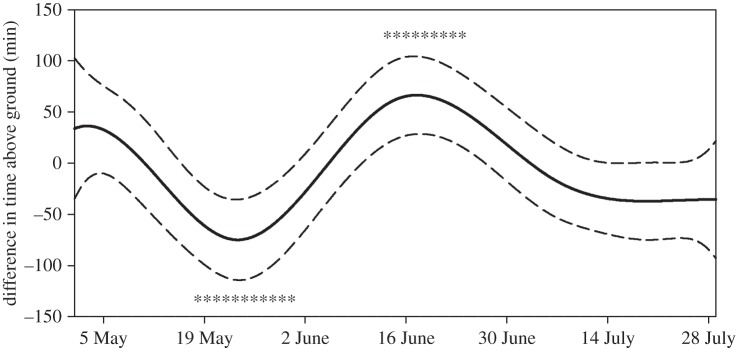
Predicted differences in p-splines between the sexes for time spent above ground each day by arctic ground squirrels across the 2014 active season at Atigun River. The solid line shows the mean prediction and the dotted lines, the 95% CIs. Negative values indicate females spend less time above ground compared with males. Asterisks indicate time intervals with significant sex differences (p < 0.05; Holm's step-down adjustment for multiple comparisons).